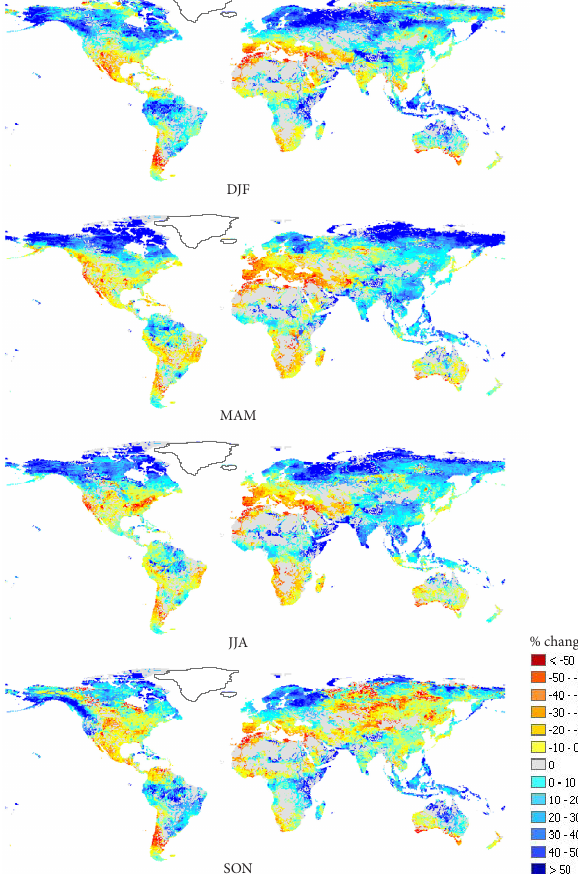
Fig. 4. Multi-model ensemble average seasonal discharge changes (%) for the scenario A1B as a percentage of the discharges cal- culated for the 20C3M control experiment. From top to bottom the seasons: December-January-February, March-April-May, June- July-August and